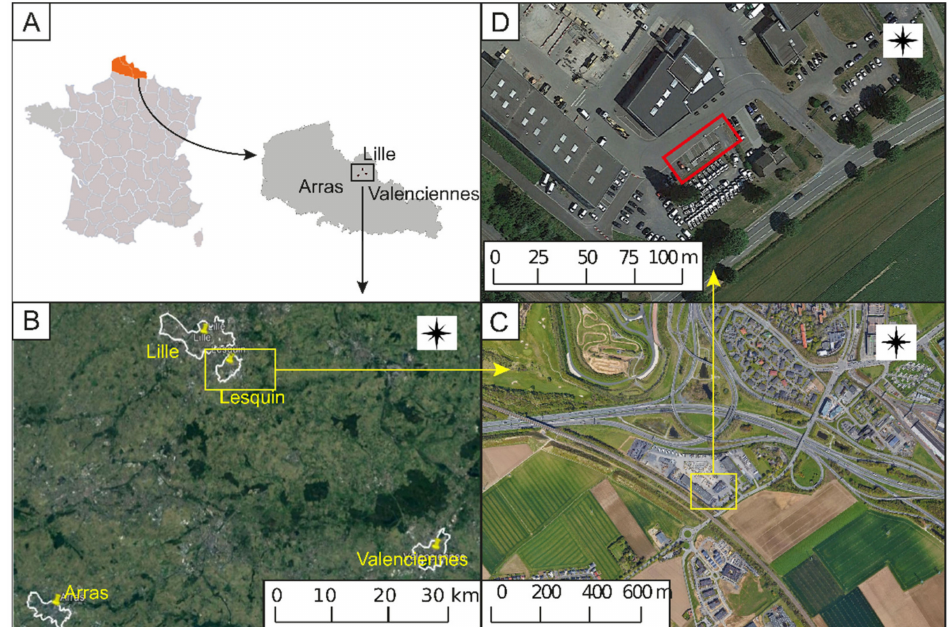
Figure 1. ( A ) Location of the cities of Lille, Arras, and Valenciennes (France); ( B ) location of the city of Lesquin compared to Arras and Valenciennes cities; ( C ) aerial view of the experimental site environment (location of the platform marked with a black box); ( D ) location of the studied parking lots (sources: Google